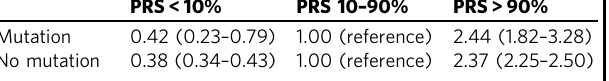
The table shows the hazard ratios and 95% con fi dence intervals for the bottom and top deciles, comparing them to women with an average risk (PRS between the 10th and 90th